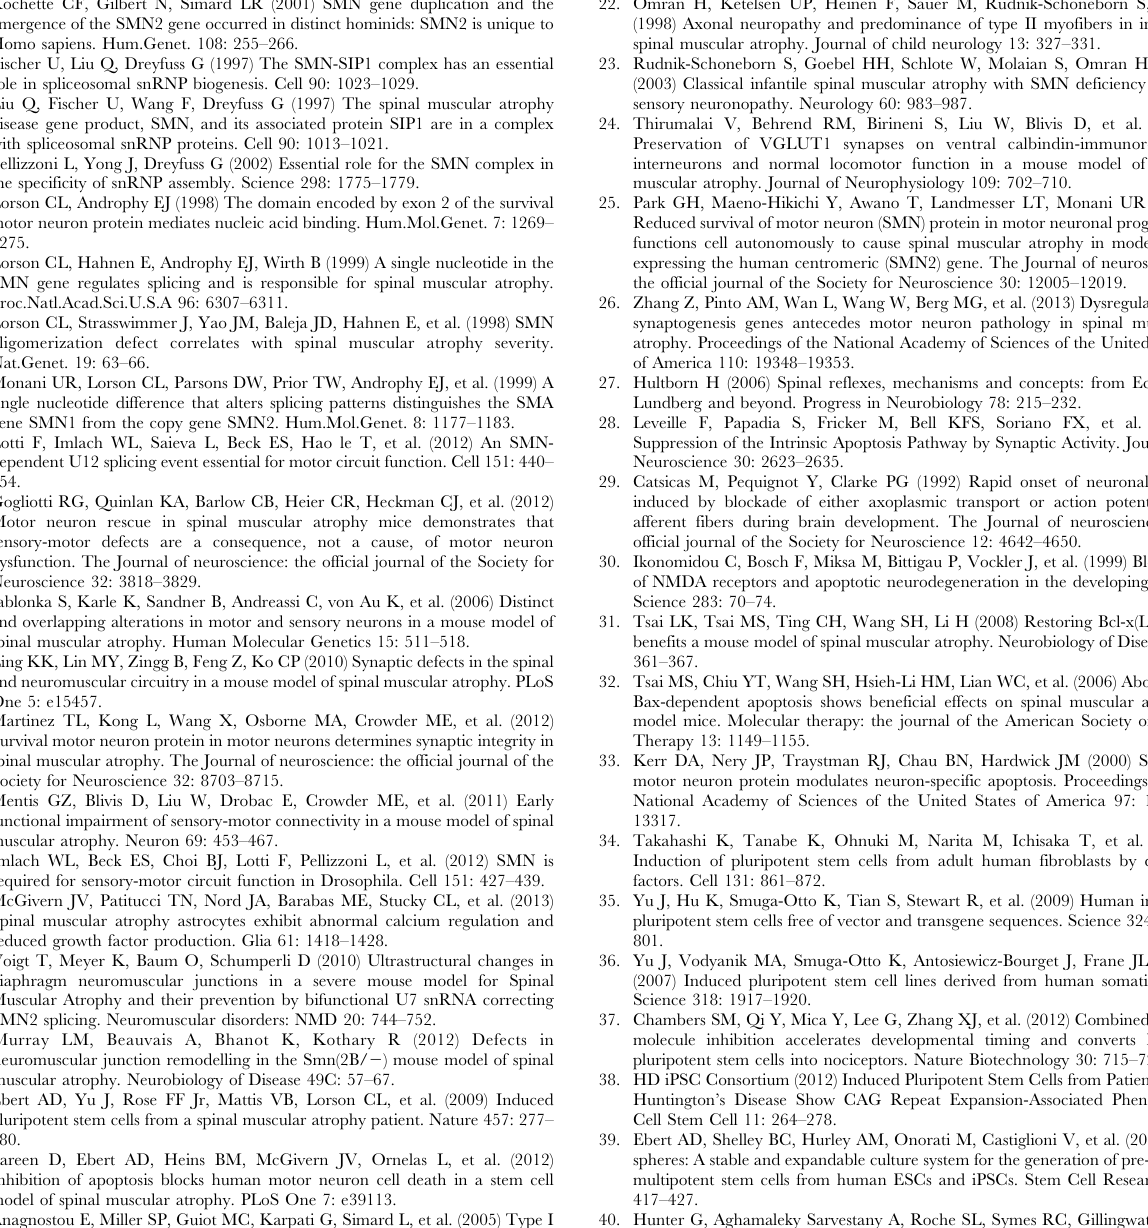
week differentiated SMA iPSC-derived motor neurons exhibit significantly fewer VGlut1 + puncta on both the cell soma (A) and neurites (B) compared to control iPSC-derived motor